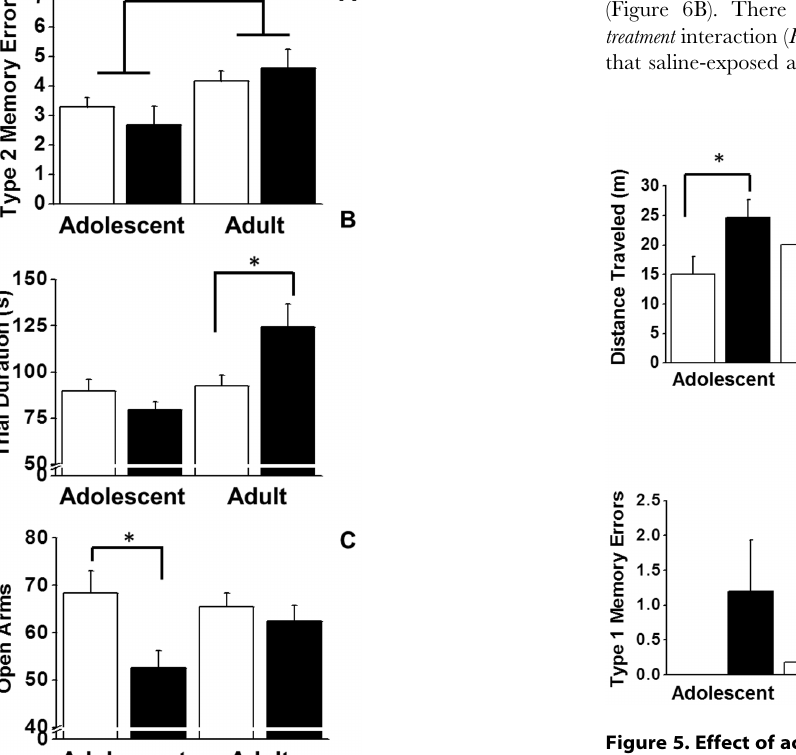
Figure 5. Effect of acute ethanol following chronic intermittent ethanol (black bars) or saline (white bars) exposure during adolescence or adulthood. Panel A and B represent distance traveled and type1 working memory errors, respectively, 30 m after administration of 1.5 g/kg EtOH i.p. during the acquisition phase of DNMTP. Bottom panels C and D represent type1 and type2 working memory errors, respectively, 90 m after administration of 1.5 g/kg EtOH i.p. during the retrieval phase of DNMTP. Data are expressed as group means + SEM (n=5 adolescent saline, n=5 adolescent CIE, n=5 young adult saline, n=7 young adult CIE, n=6 adult saline, n=6 adult CIE). Asterisks denote a significant difference between the animals pre- treated with ethanol vs. saline during adolescence (All Post-hoc t-tests, p , 0.05).